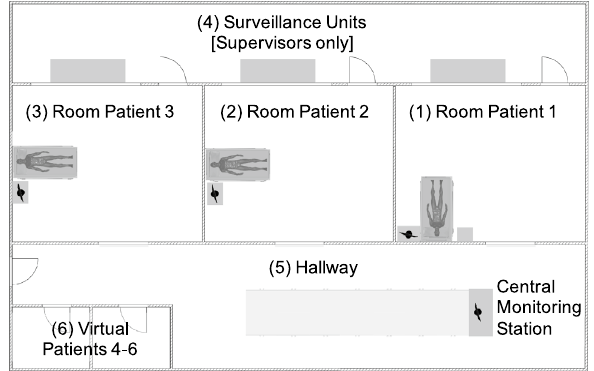
Figure 1. Floor plan of the conducted simulation. (4) was not accessed by the